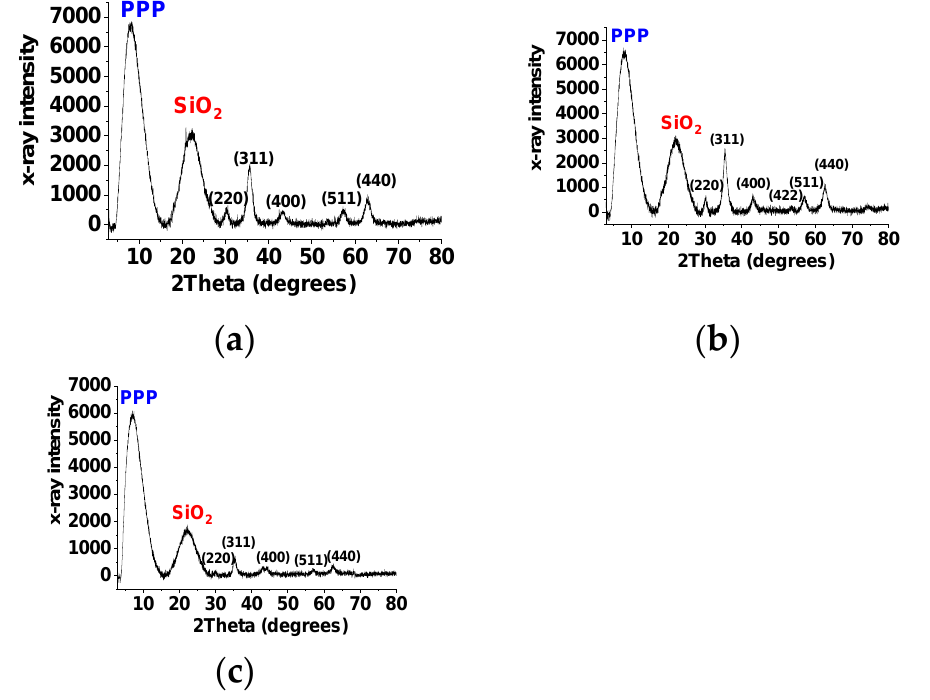
Figure 4. XRD patterns of SiO 2 -Fe 3 O 4 -PPP ( a ); SiO 2 -Fe 3 O 4 -PPP-Cr-Zn ( b ); SiO 2 -Fe 3 O 4 -PPP-Cr-Ni ( c ). In case of composite without Fe 3 O 4 only the signals corresponding to PPP and SiO 2 are presented in diffractogram (Figure S7a). This suggests the formation of amorphous Cr- and Zn-containing species. At the same time, for Al 2 O 3 -based composites containing Fe 3 O 4, the diffraction pattern contains a set of peaks corresponding to Al 2 O 3 and reflections attributed to Fe 3 O 4 structure (Figure S7b,c). Similar to composites based on SiO 2 -, the reflections characteristic for Cr and Zn oxides are